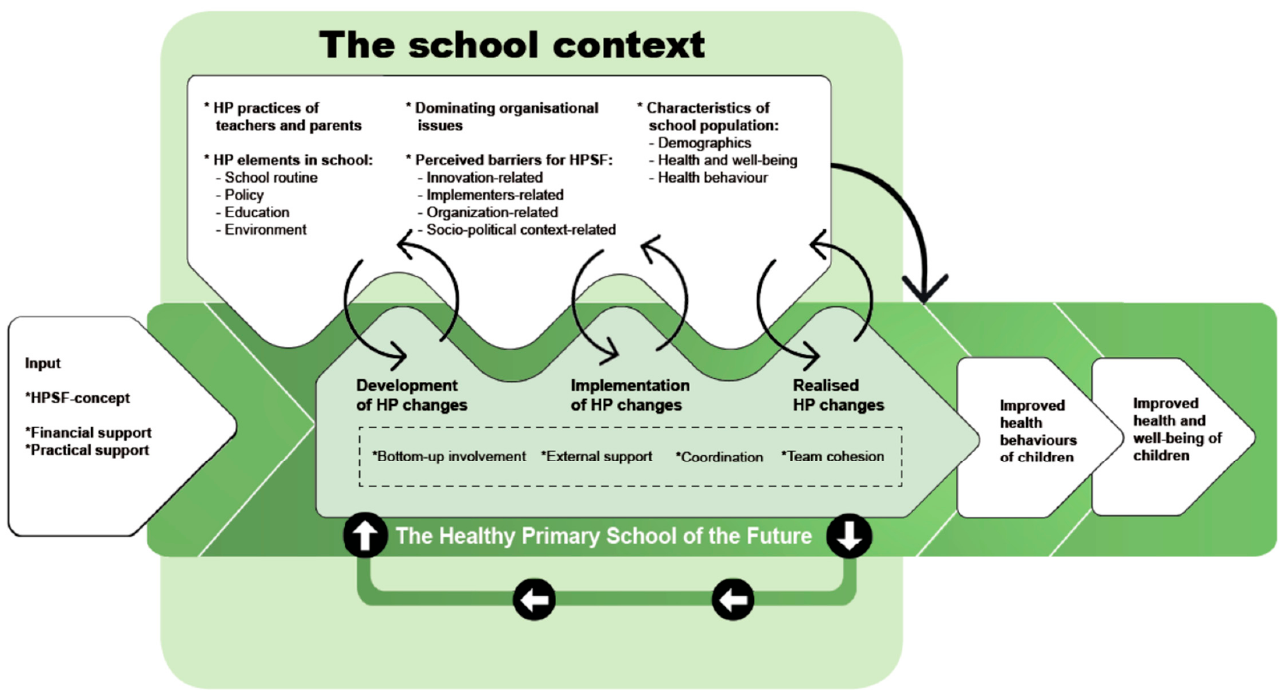
Figure 1. Program theory derived from Bartelink et al. [28]. The left side of the model shows the input, which is an ‘event’ that attempts to positively disrupt the pre-existing dynamics in the school context to integrate health promotion. After the introduction of HPSF into the school context, the process of development, implementation, and integration of HP changes develops in the school. During this process, it is hypothesized that HPSF will continuously interact with the school context. The loop in the bottom of the program theory visualizes the key assumption that realized changes may shift the school’s norms toward a focus on health and well-being, thereby creating momentum for additional HP changes. Overall, the process of change should lead to the realization of HP changes that fit the school’s context. The combination and interaction of all these contextualized HP changes should impact children’s health behaviors and, through this, their health and well-being. A key assumption in the cause–effect relation concerns non-linearity: it is assumed that small changes in a school can produce large effects at a so-called ‘tipping’ point. The arrow in the top right of the model visualizes the moderating role of the school context. The key assumption is that even when a change is similar, the school context will determine its impact.